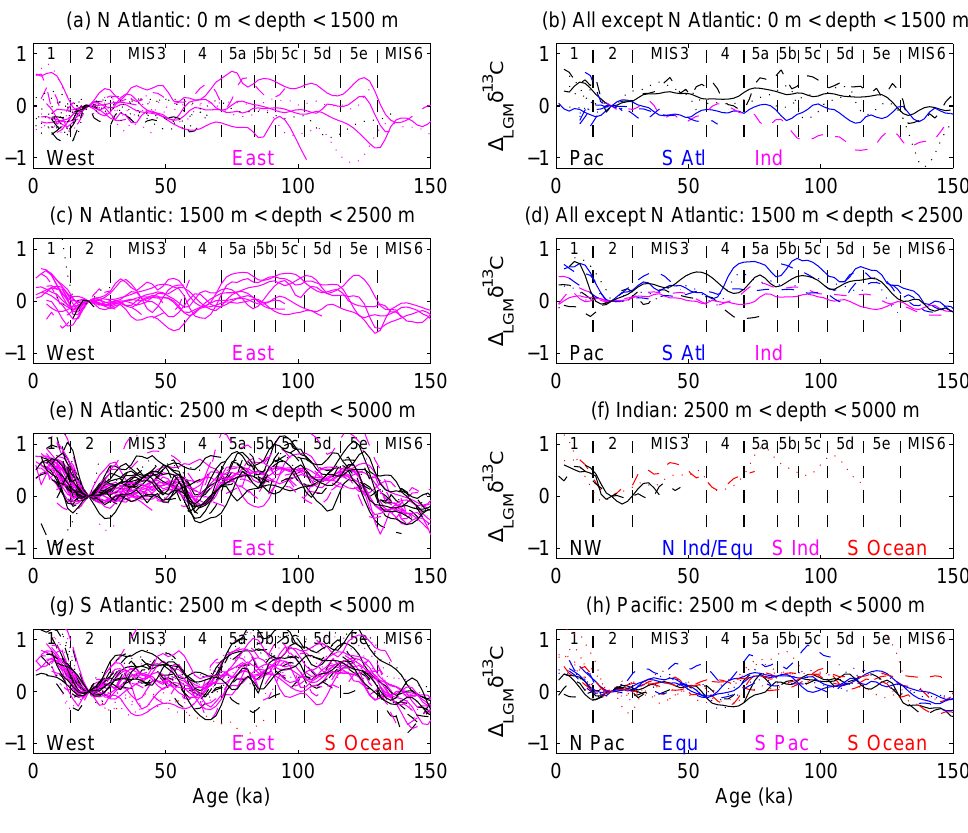
Fig. 6. Benthic ∆ LGM δ 13 C ( δ 13 C as an anomaly relative to the 21 ka value) time-series by region. Error estimates are < 0.25 ‰ (solid), < 0.5 ‰ (dashed), < 0.8 ‰ (dotted); data with larger error estimates are not plotted. Colours indicate sub-regions: meridional boundaries are at the mid-ocean ridge (Atlantic) and 75 ◦ E (Indian). Equatorial cores are within 8 ◦ of the Equator. Marine Isotope Stages are indicated in each panel.